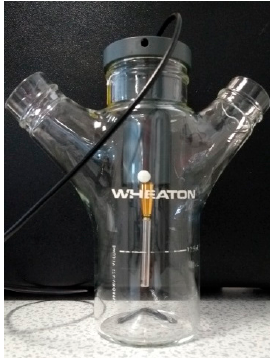
Figure 2. Photograph of the hydrophone arrangement within the Celstir vessel set-up for ultrasonic intensity measurement.